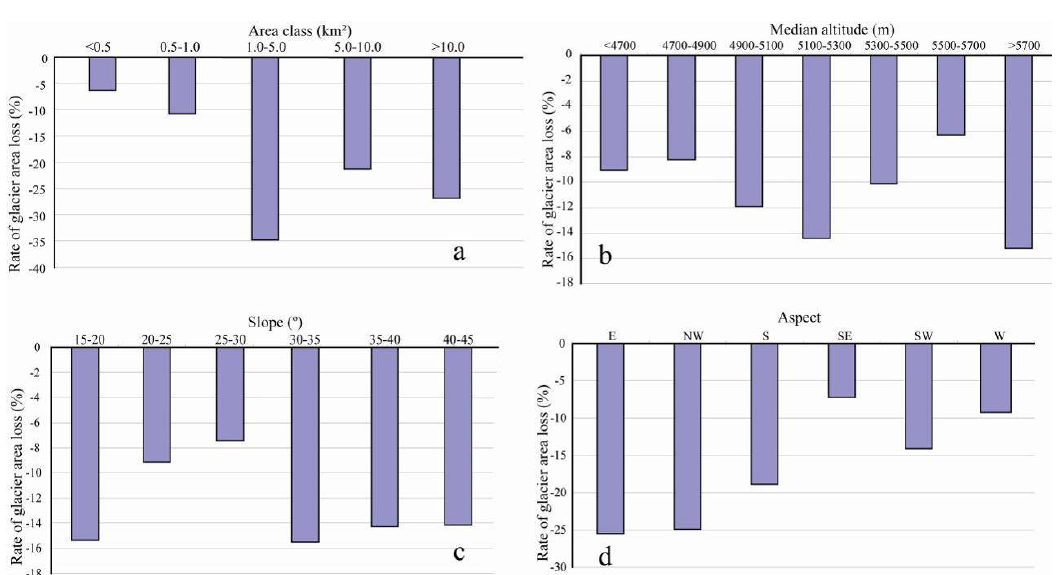
Fig. 4. The glacier changes between 1966 and 2009. (a) The relationship between area changes and area class. (b) The relationship between area changes and median altitude. (c) The relationship between area changes and mean slope. (d) The relationship between area changes and aspect.